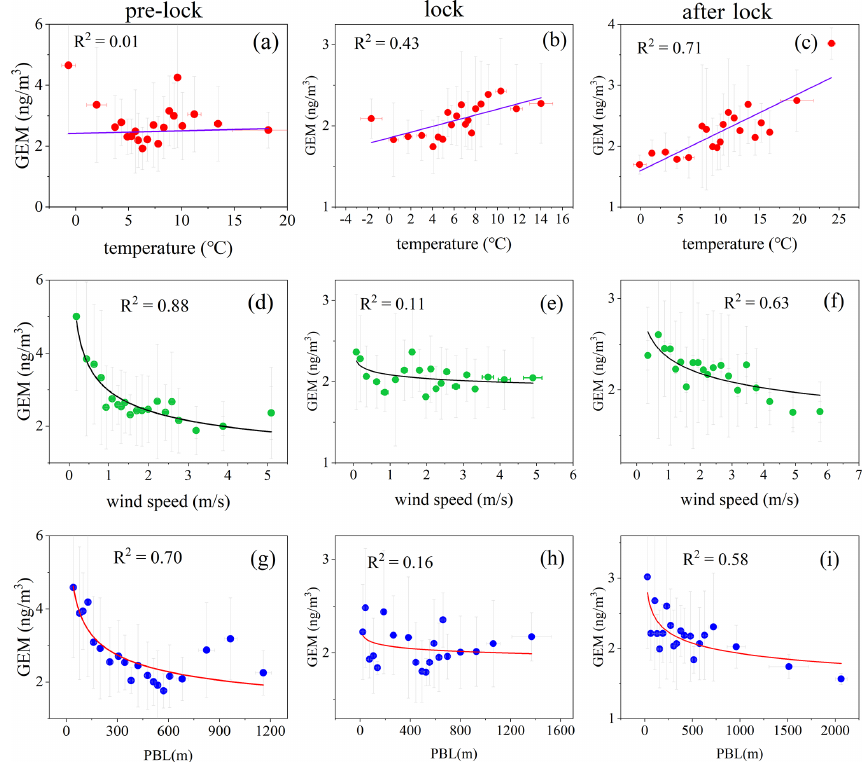
Figure 3. Relationship between GEM concentration and (a–c) temperature, (d–f) wind speed, and (g–i) PBL height before, during, and after the